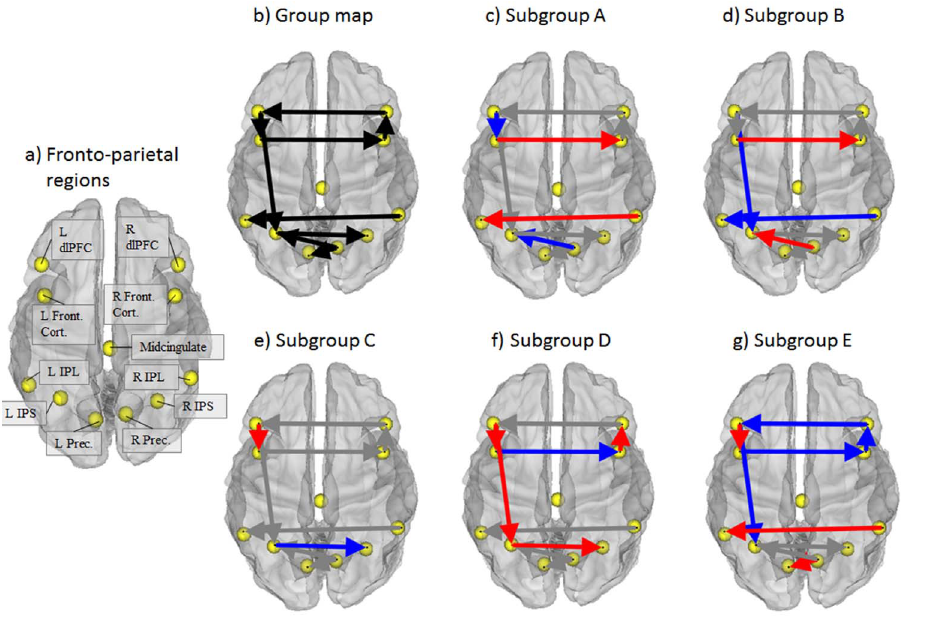
Figure 5. Regions and results from empirical sample. Red lines indicate the subgroup had higher connection values than the average of the other subgroups; blue lines indicate the subgroup had lower connection values than the average of the other subgroups; gray paths indicate the connection values were similar to the average of other subgroups. Abbreviations: ‘‘dlPFC’’=dorsolateral prefrontal cortex; ‘‘FC’’=frontal cortex; ‘‘IPS’’=intraperietal sulcus; ‘‘IPL’’=inferior parietal lobule; ‘‘R’’ preceding these ROI names and abbreviations denotes right and ‘‘L’’ denotes left.